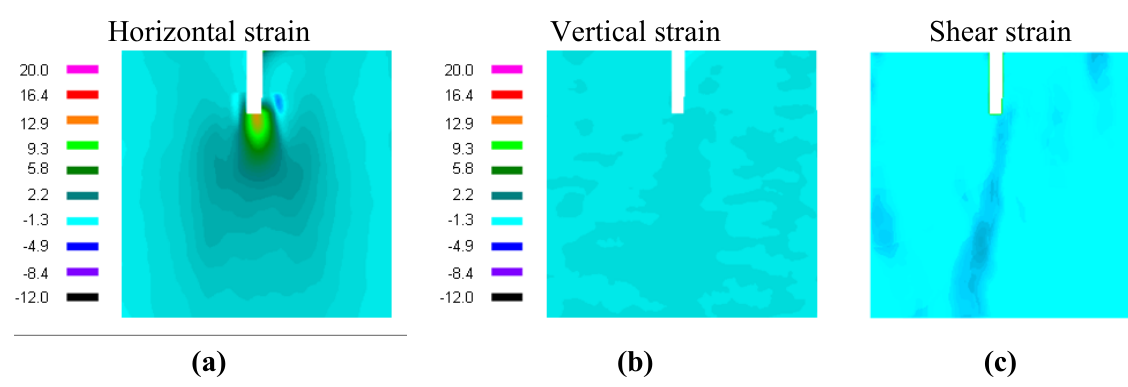
Figure 3. ( a ) measured in-plane horizontal strain distribution ε ; and ( c ) shear strain profile. vertical strain profile ε yy